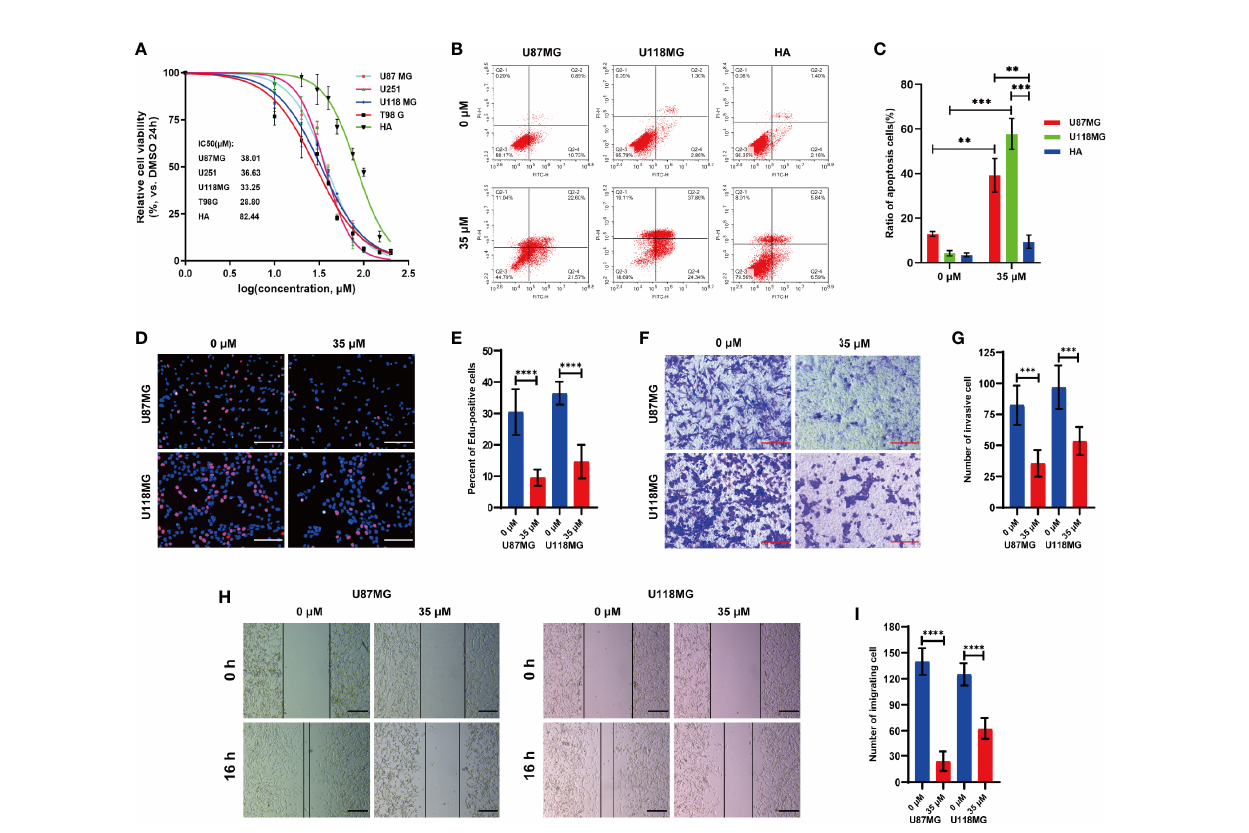
FIGURE 6 | P7C3 inhibits glioma in vitro . (A) The cell viability curve of different P7C3 concentration effects on four glioma cell lines and human astrocytes (HA) (n = 4). (B) Cell apoptosis assay after U87MG, U118MG, and human astrocytes were treated with P7C3 (0 m M and 35 m M) for 24 h (n = 4). (C) Statistical analysis of apoptotic cells. P7C3 signi fi cantly increased the ratio of apoptotic cells in U87MG and U118MG cells, but the ratio of apoptotic human astrocytes was signi fi cantly less (n = 3). (D) EdU incorporation assay after U87MG and U118MG cells were treated with P7C3 (0 m M and 35 m M) for 24 h. (E) Statistical analysis of the percentage of EdU-positive cells. P7C3 signi fi cantly decreased the percentage of EdU-positive U87MG and U118MG cells after P7C3 treatment (n = 12). (F) Cell invasion assay after U87MG and U118MG cells were treated with P7C3 (0 m M and 35 m M) for 24 h. (G) Statistical analysis of the invasive cells. P7C3 signi fi cantly decreased the number of invasive U87MG and U118MG cells after P7C3 treatment (n = 6). (H) Wound-healing assay after U87MG and U118MG cells were treated with P7C3 (0 m M and 35 m M) for 16 h. (I) Statistical analysis of migrating cells. P7C3 signi fi cantly decreased the number of migrating U87MG and U118MG cells after P7C3 treatment (n = 6). (The data were expressed as mean ± SD, ** P < 0.01, *** P < 0.001, **** P <